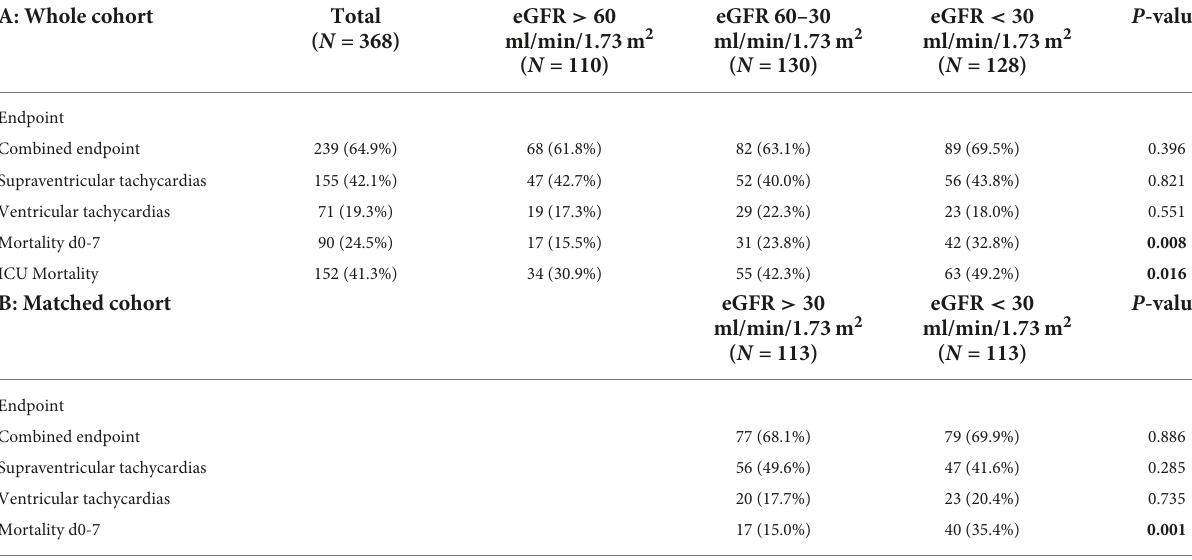
TABLE 3 Primary and secondary endpoints in the whole cohort (A) and the matched cohort (B)